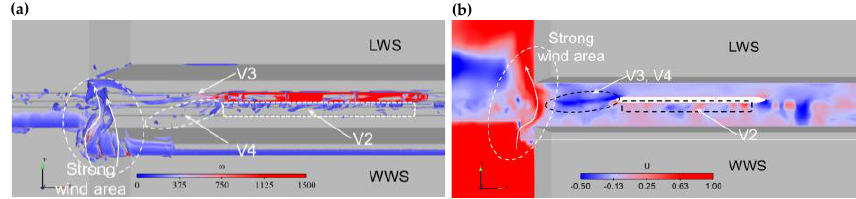
Figure 16. Flow field distribution at t * = 94: ( a ) vortex around the train ( Q = 5000) and ( b ) velocity distribution at a height of 0.5 h.